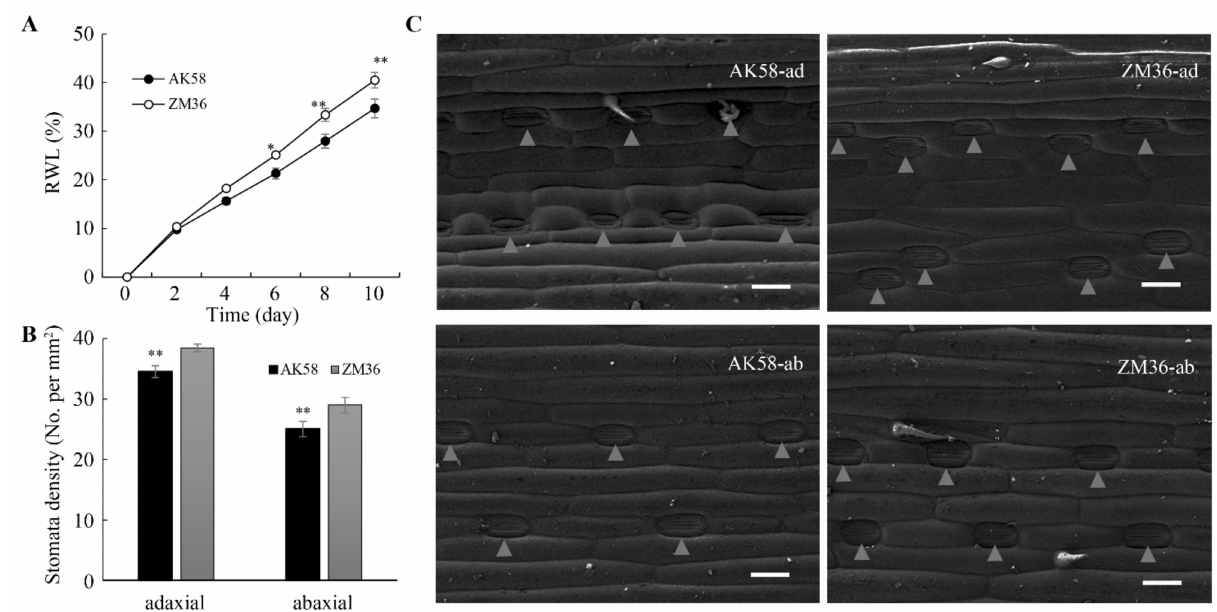
Figure 3. ZM36 has a higher leaf RWL and stomatal density than AK58. ( A ) RWL of AK58 and ZM36 plants. ( B ) Stomata density of AK58 and ZM36. Data represent means ± SE. *, t -test with p < 0.05; **, t -test with p < 0.01. ( C ) SEM analysis of the adaxial (ad) and abaxial (ab) epidermis of AK58 and ZM36. Triangles indicate stomata. Scale bars = 100 µ